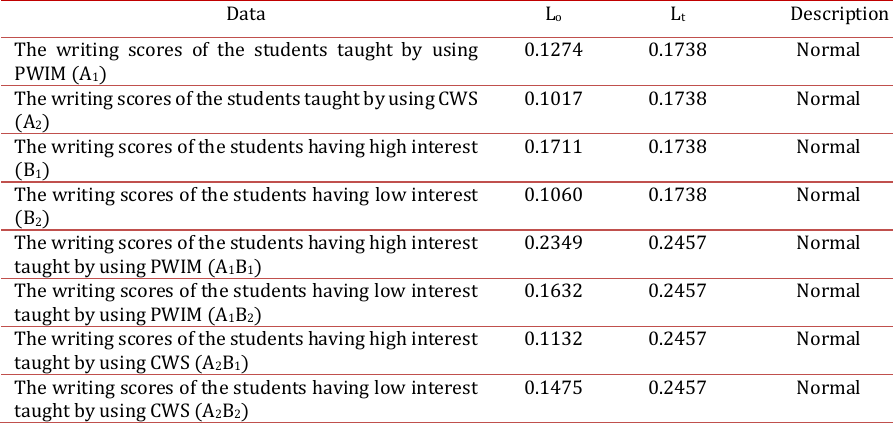
Table 1. The Summary of Normality Test Data L o L